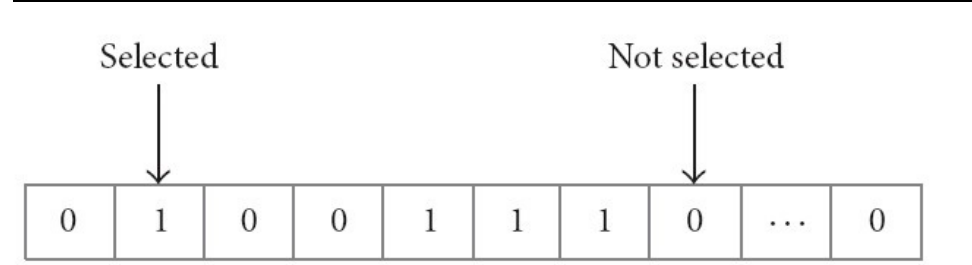
Figure 7. A flag vector for feature selection. Algorithm 2. The pseudocode of the IGWO.